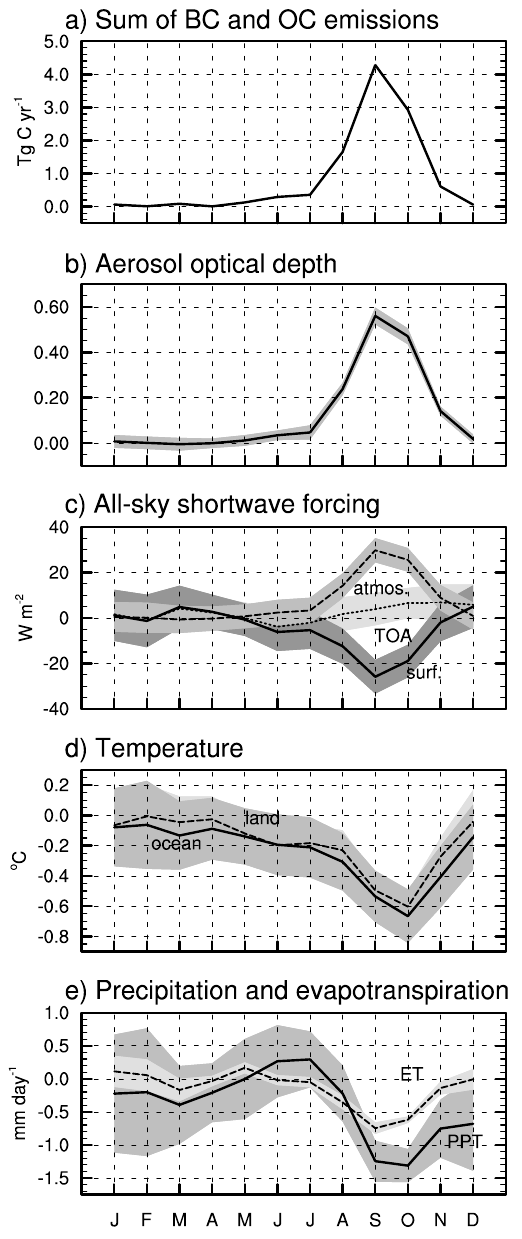
Fig. 3. Climate forcing and response from the two CAM3 sim- ulations described in the text. Each plot shows the annual mean cycle of the difference between the high fire simulation and low fire simulation over the study area (90 ◦ E–120 ◦ , 5 ◦ S–5 ◦ N). (a) The GFEDv2 fire emissions used to force the model are in units of Tg month − 1 . (b) Aerosol optical depths simulated by CAM3 in response to these emissions (unitless). (c) All-sky net shortwave radiation at the surface, for the troposphere, and at the top of the atmosphere (TOA) from the model in units of Wm − 2 . (d) Sea sur- face temperatures (solid line) and land surface temperatures (dashed line) in units of ◦ C. (e) Precipitation (solid line) and evapotranspi- ration (dashed line) in units ofmmd − 1 . Gray error bars denote 95% confidence